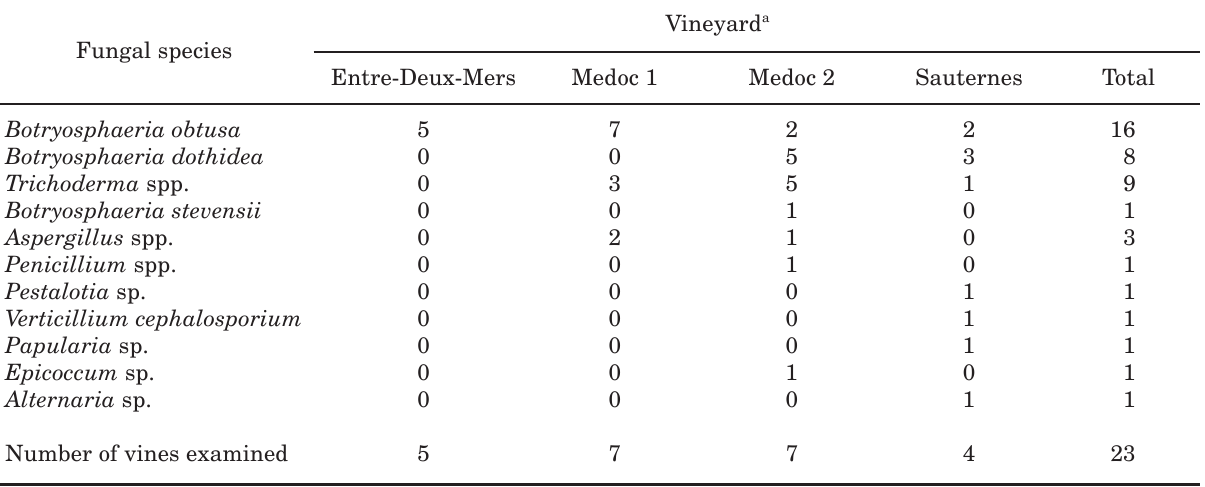
Table 2. Fungi associated with black dead arm symptoms in vines taken from four different vineyards in the Bor- deaux region of France.